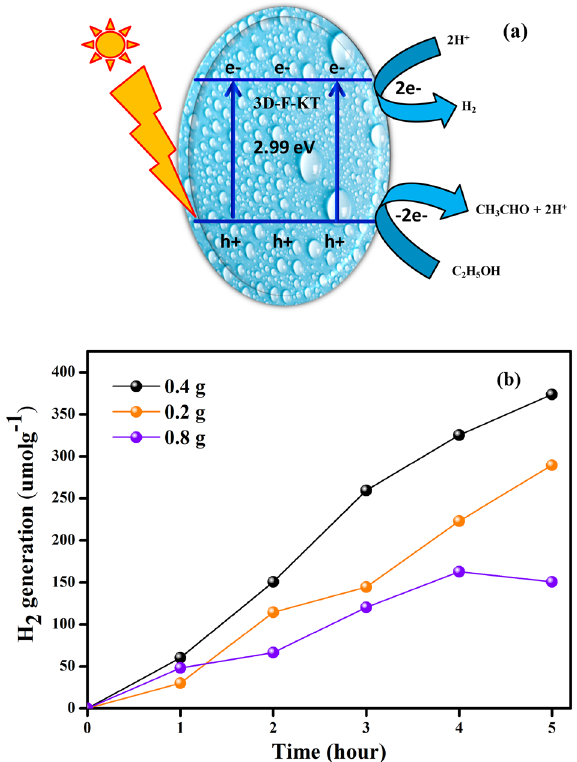
Figure 10. ( a ) Schematic representation of photocatalytic H 2 production under UV–visible light irradiation. ( b ) 3D-F KT prepared by 0.4 g concentration of areca seed powder shows higher H 2 generation than other 2